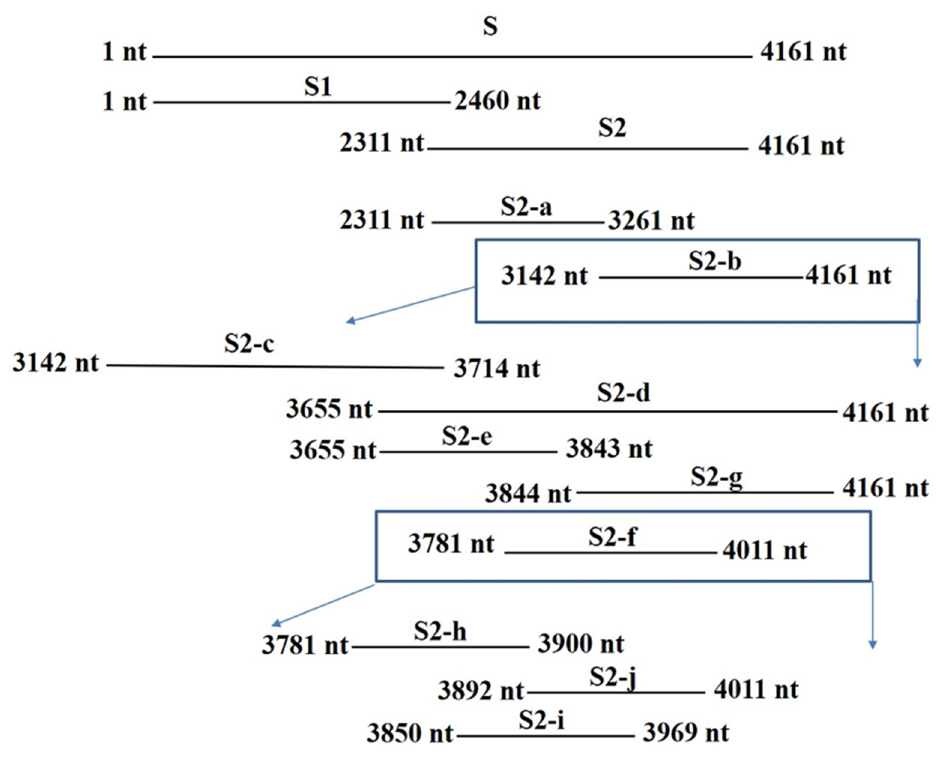
Figure 4. Schematic diagram of the PEDV S fragments used for B-cell epitope mapping. Four rounds of S peptides were conducted to investigate epitopes of the generated mAb.